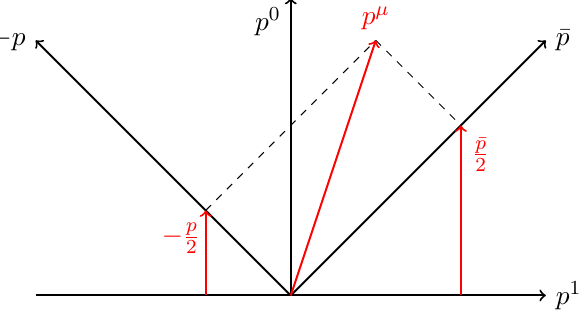
Figure 2 . The Penrose diagram of 2 d Minkowski space. The coordinates w; (cid:22) w are related to the z; (cid:22) z coordinates as z = tan w and similarly for (cid:22) z . The dashed lines mark the integration contours of the ANEC operators (2.2), which in these coordinates read E = (cid:0) 1 = 2 (cid:25) R dw cos 2 w T ( w ) | up to the vacuum energy which we subtracted o(cid:11) | and similarly for (cid:22) E . The contours can be freely translated, therefore E measures the total energy | equal to the (cid:22) z component of the momentum | which reaches in(cid:12)nity on the right, and similarly (cid:22) E .